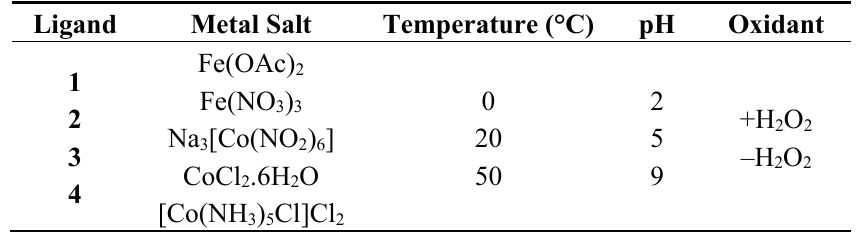
Table 1. Summary of variables screened in nitrile turnover